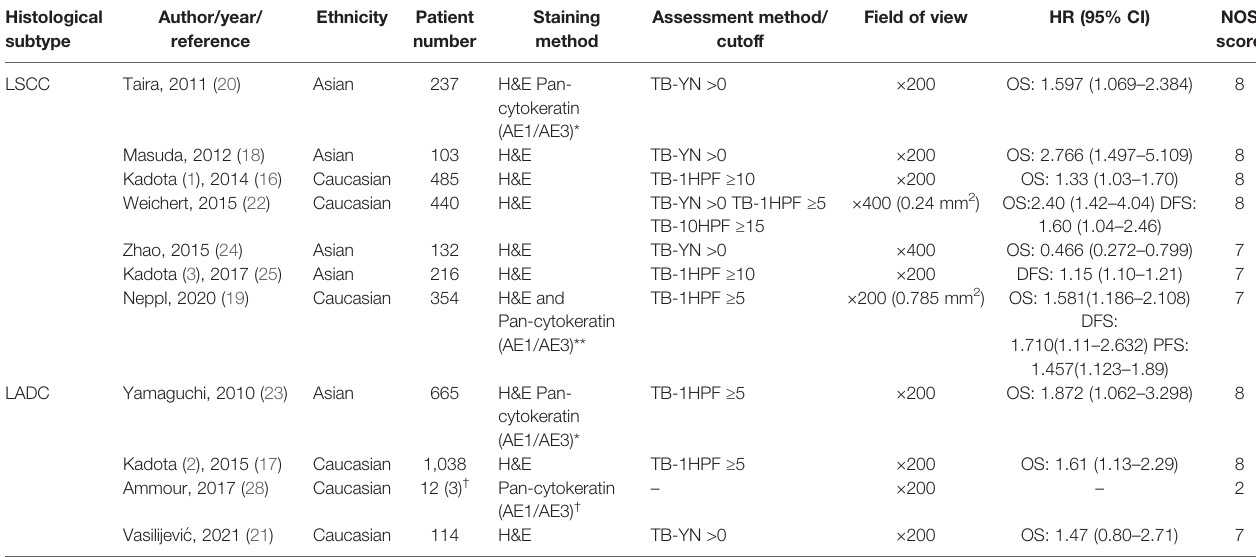
TABLE 1 | Main characteristics of all lung cancer included studies.